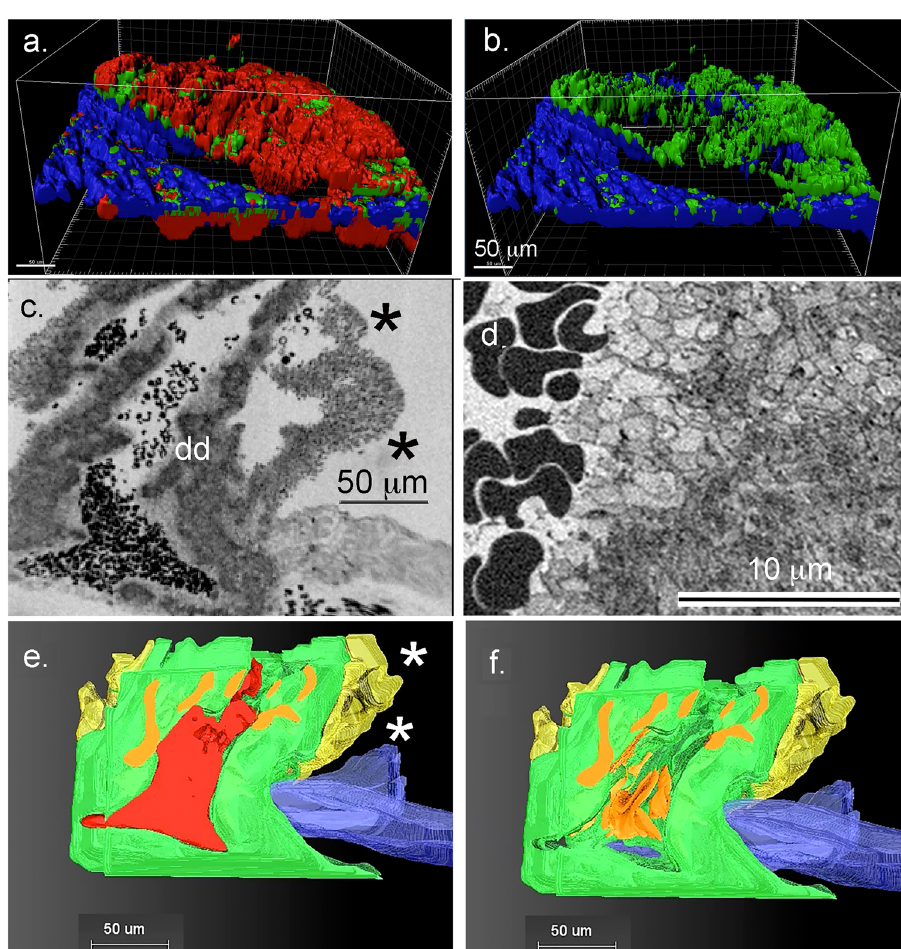
Fig. 2 Bleeding cessation is through extravascular capping the vaulted 5 min post-puncture thrombus. a / b Rendered images from 2P, light microscopy of a 5 min thrombus. a Three-color image: Red, CD 41 staining, a general platelet stain; Green, p-selectin antibody staining, an indicator of platelet α - granule secretion, Blue, fi brin. b Two-color: p-selectin (green) and fi brin (blue). Much of this staining is extravsascular 14 , c Raw image, SBF-SEM, 100 nm XY pixel size in a raw captured image, mid-thrombus, showing an extravascular platelet layer that caps the puncture hole from the extravascular side. Asterisks, loosely adherent platelets. dd, approximate area shown in ( d ). d Raw image, SBF-SEM, 20 nm XY pixel size in a raw captured image of an area approximating dd in frame ( c ). Note that morphologically the platelets are most activated, i.e., degranulated on the surface of the column and least at the center. Furthermore, the trapped RBCs are distorted in shape, tending to polyhedral morphology. e / f 3D rendering of the thrombus with and without red blood cells (RBCs). RBCs, red; tightly adherent platelets, green, degranulated platelets, orange; loosely adherent platelets, yellow; vessel wall,